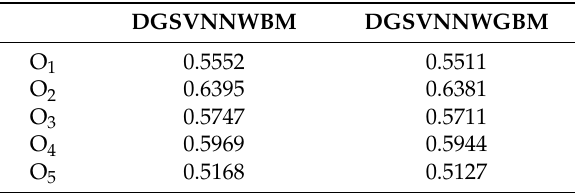
Table 2. The scores of the strategic suppliers.